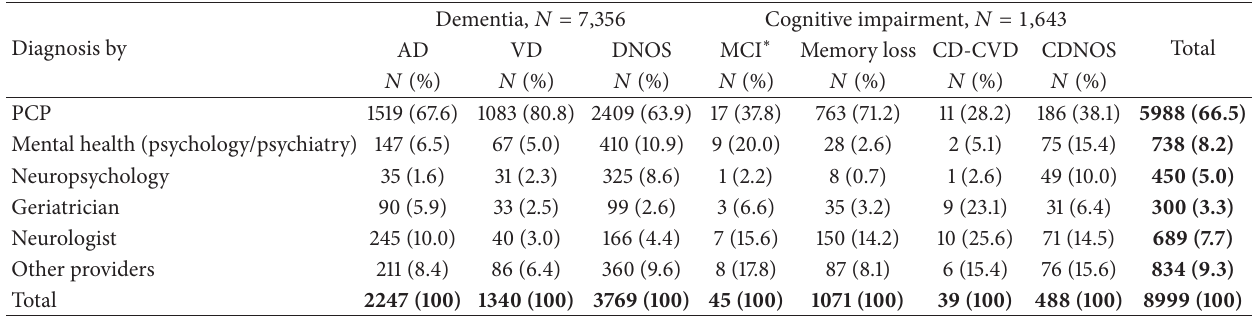
Table 1: Initial dementia diagnoses by provider type.